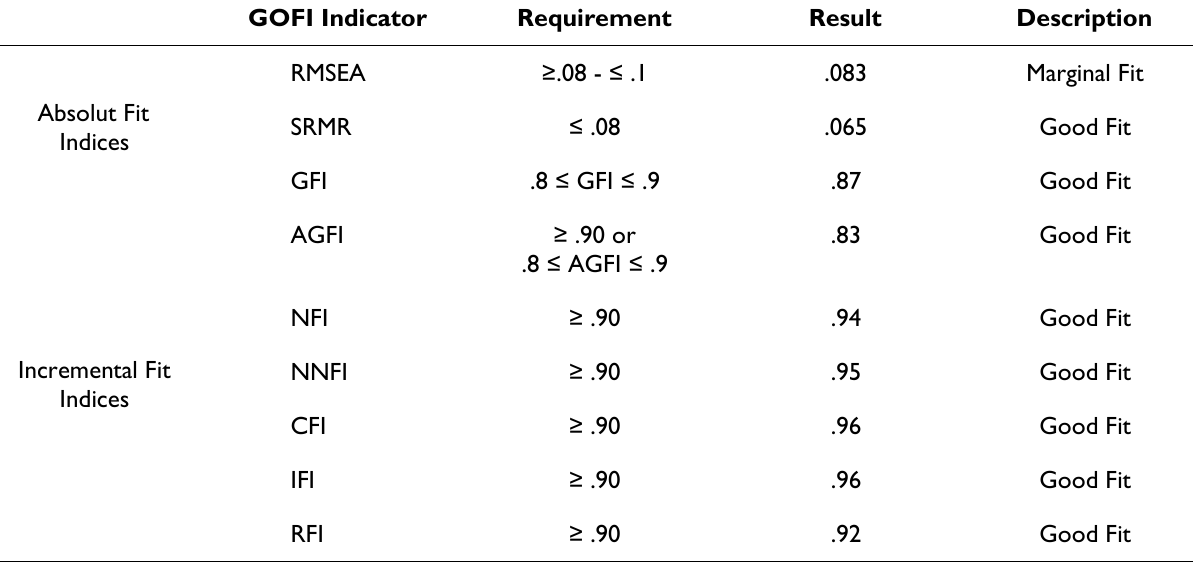
Table 5. Good Fit